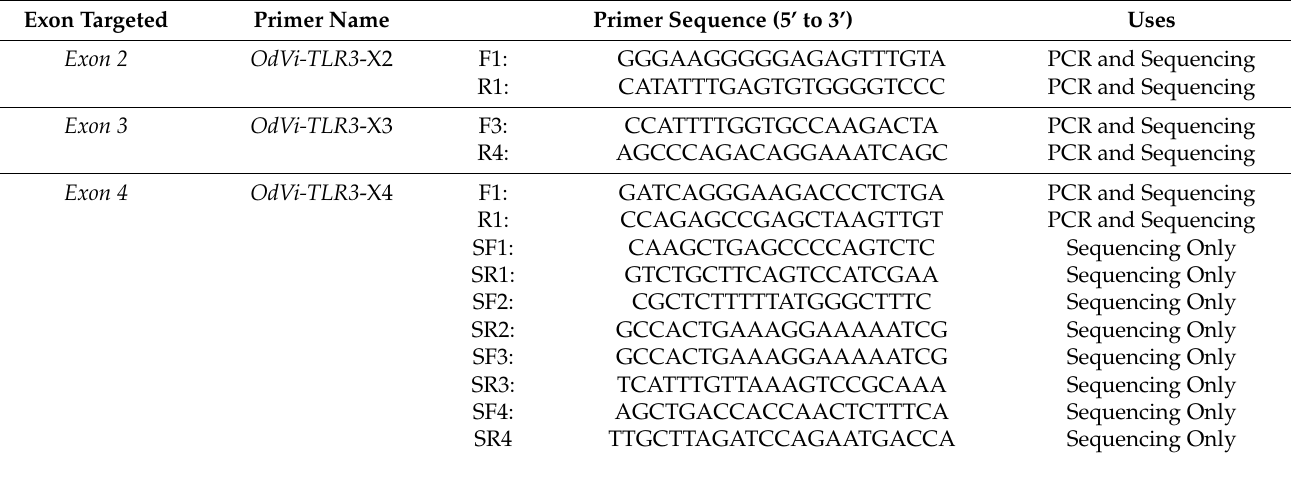
Table 1. List of primers designed to amplify and sequence the complete coding region (in exons two through five) of TLR3 in white-tailed